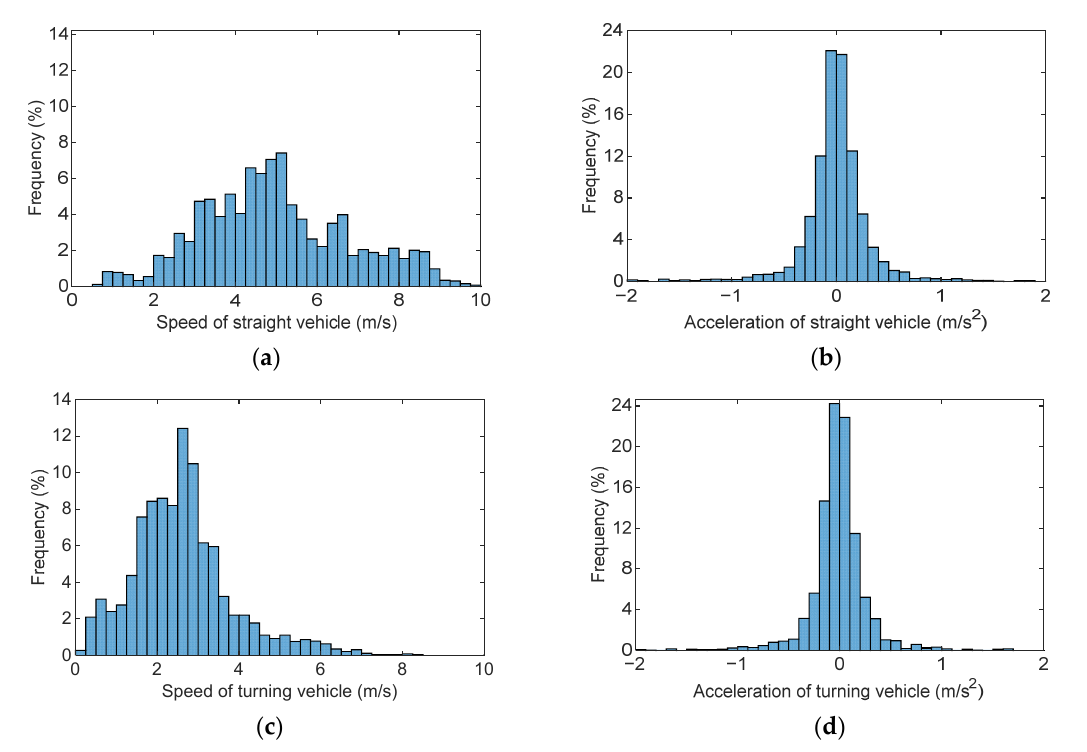
Figure 8. Statistical histogram of track information when the straight vehicle goes ahead: ( a ) speed of straight vehicle, ( b ) acceleration of straight vehicle, ( c ) speed of turning vehicle, and ( d ) acceleration of turning vehicle.